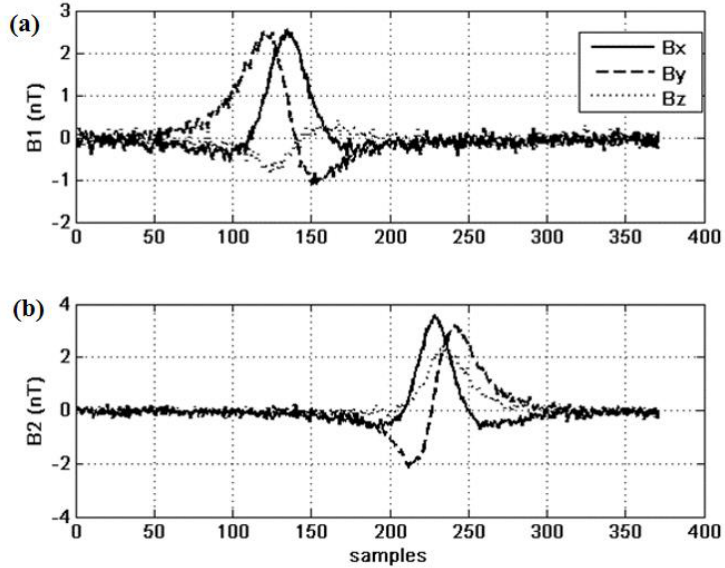
Figure 2. Raw data from the two sensors S1 ( a ) and S2 ( b